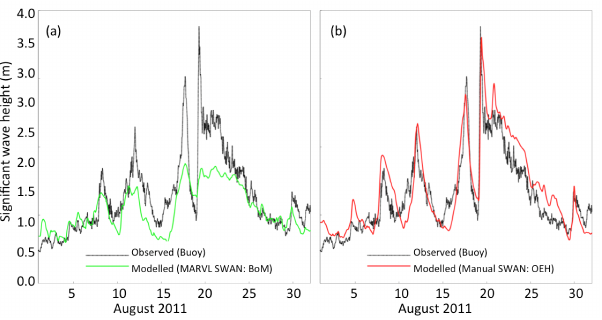
Figure 9. Time series of modelled (colour) and observed (black) significant wave height off Sydney ( ∼ 1km offshore, in 21m of wa- ter), for two different model configurations – (a) MARVL SWAN: BoM and (b) Manual SWAN: